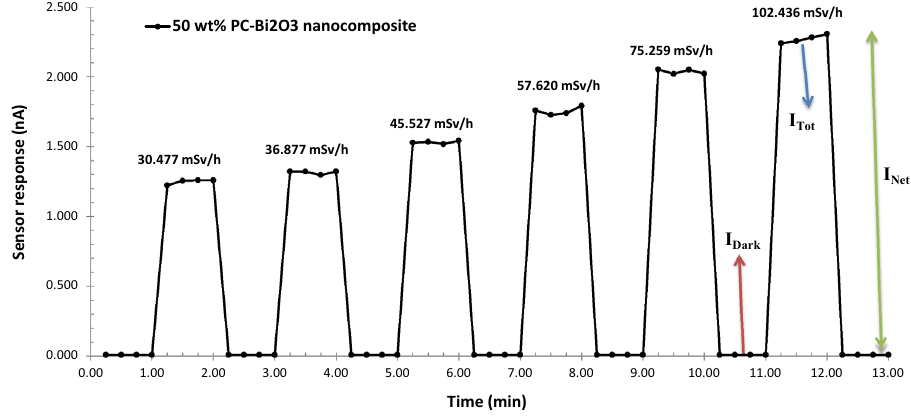
Figure 8. Time evolution of the sensor response at different dose rates for the 50 wt% PC–Bi 2 O 3